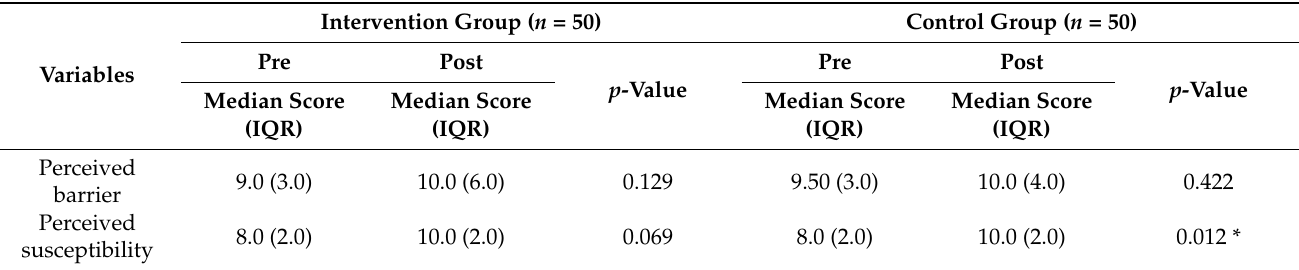
Table 6. Perceived barrier and perceived susceptibility score before and after intervention among respondents towards food poisoning preventive behaviour during dining out ( n =